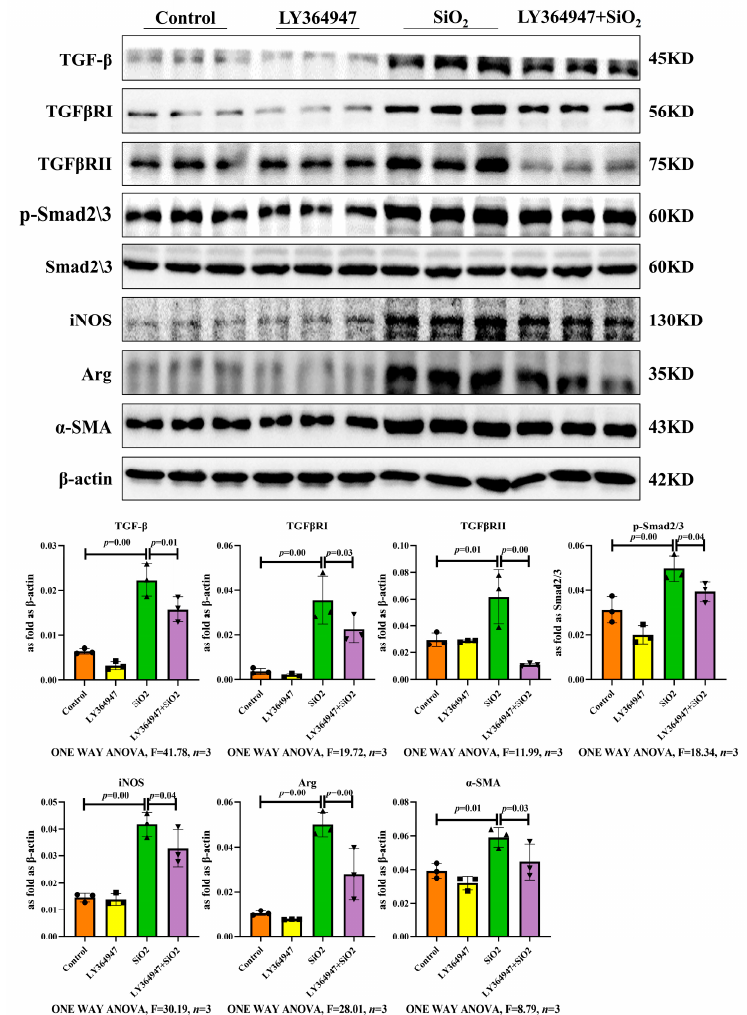
Figure 10. The expressions of TGF- β , TGF β RI, TGF β RII, p-Smad 2/3, iNOS, Arg, and α -SMA in SiO 2 -treated MH-S, measured by Western blot. Data are presented as the mean ± SD, n = 3 per group.